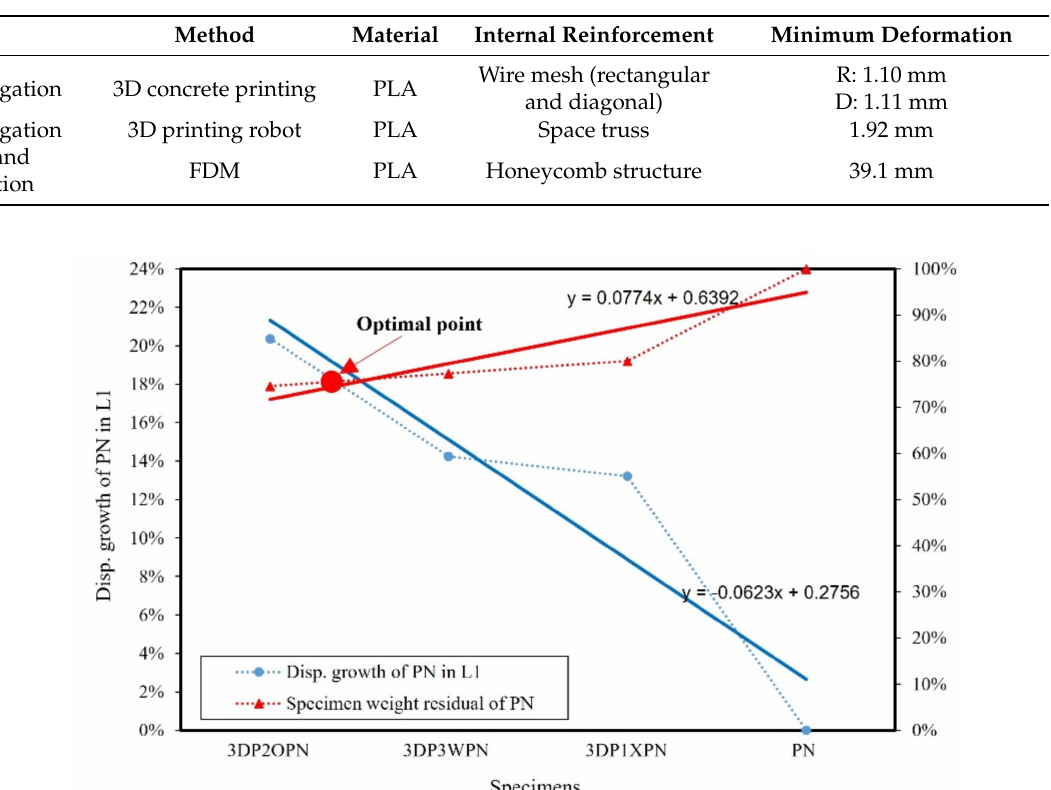
Table 11. List of 3D printed cladding methods and minimum deformation.